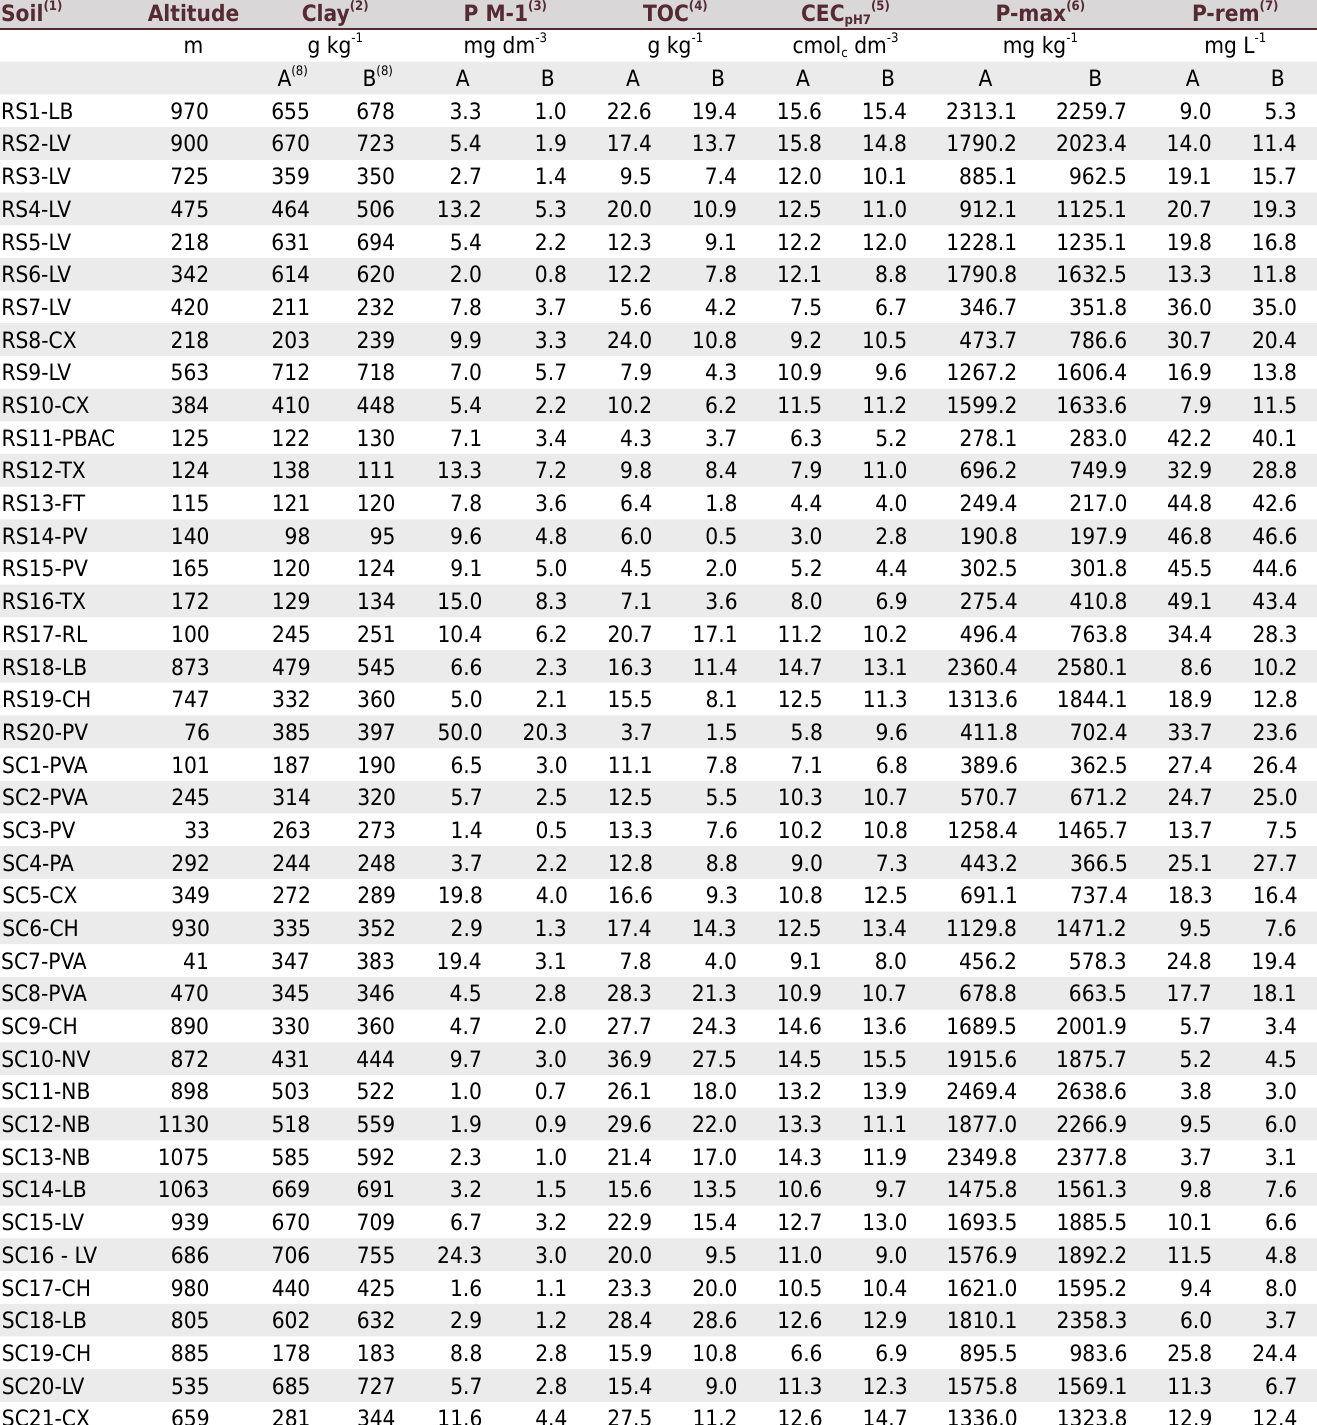
Table 1. Identification, classification, location, and characterization of soils collected in the states of Rio Grande do Sul (RS) and Santa Catarina (SC) Soil